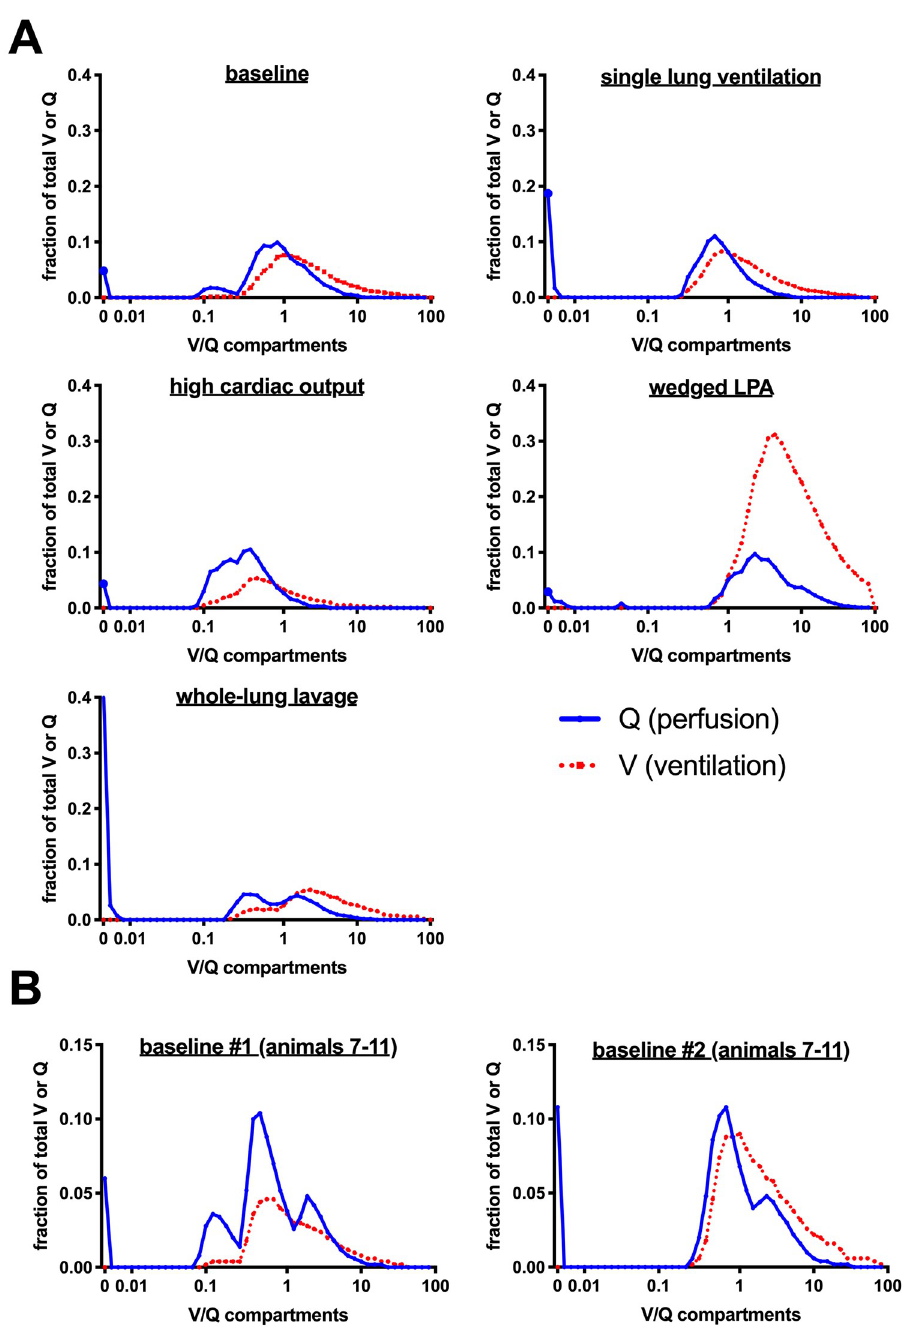
Fig 4. V/Q distributions measured by MMIMS-MIGET. A , Pooled V/Q distributions of all MMIMS-MIGET measurements and B , V/Q distributions of the first and second baseline conditions for animals 7–11. On the y-axis fractional perfusion (Q) and ventilation (V) with respect to cardiac output or minute ventilation are depicted. On the x-axis, the 50 V/Q compartments as measured by MMIMS-MIGET are displayed. Compartment “0” is intrapulmonary shunt. Fractional perfusion and ventilation are presented as blue lines and red dots,